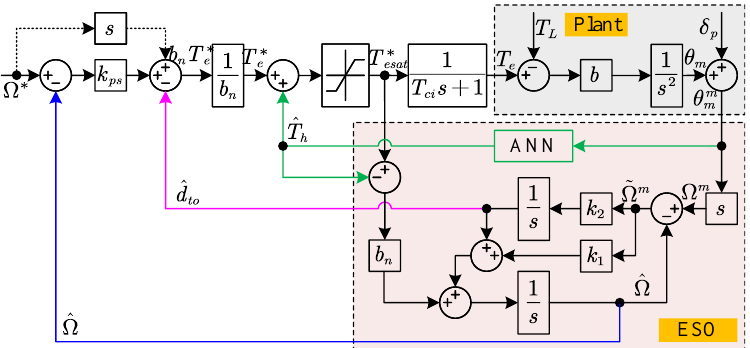
Figure 2. Block diagram of the NN-ESO-ADRC system with single input.